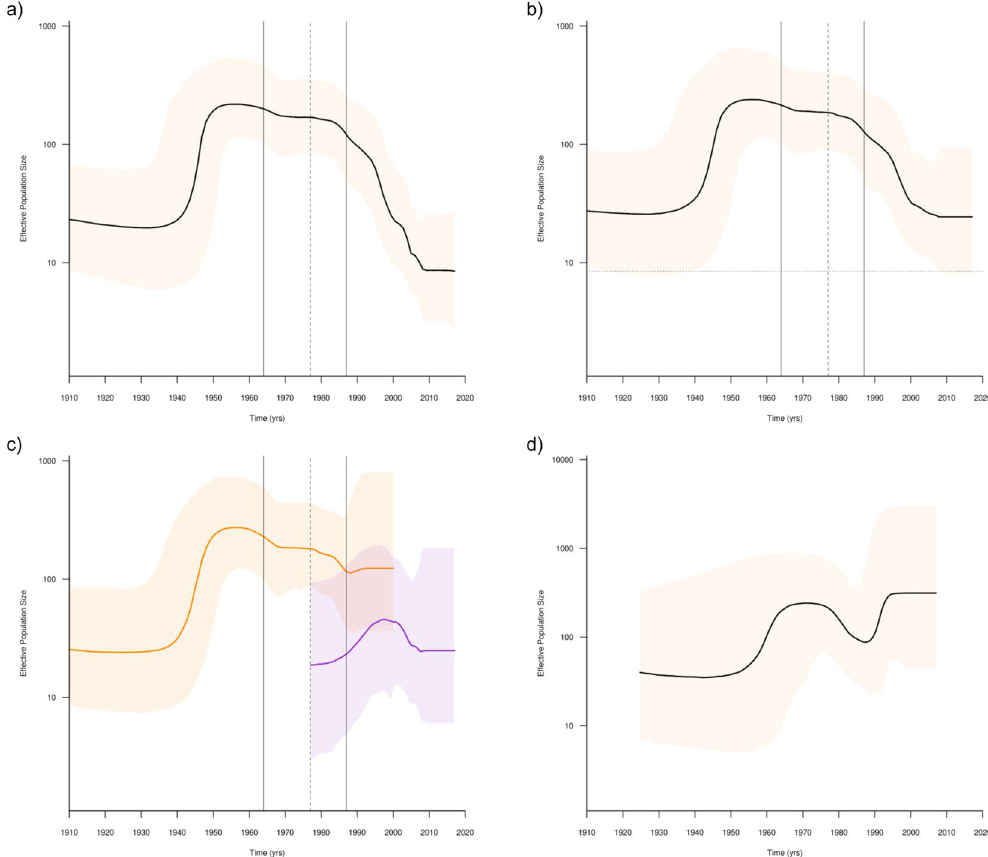
Figure 3. Demographic history of YFV genotypes I and II in the Americas. Mean estimates of the effective number of infections ( N e ) (solid line) are shown together with the 95% HPD intervals (shaded area) of the Bayesian skyline for whole Genotype I dataset ( a ), Genotype I subsampled dataset ( b ), Genotype I old-lineages (orange line) and modern-lineage (purple line) ( c ), and Genotype II ( d ). Vertical segmented and continuous lines in demographic plots of panels a, b and c represents the estimated mean T MRCA for the genotype I modern- linage and its 95% HPD interval, respectively. Horizontal segmented line in panel b represents the median Ne value at present estimated with the complete Genotype I dataset. The vertical axes represent the estimated N e on a logarithmic scale. Time scales are in calendar